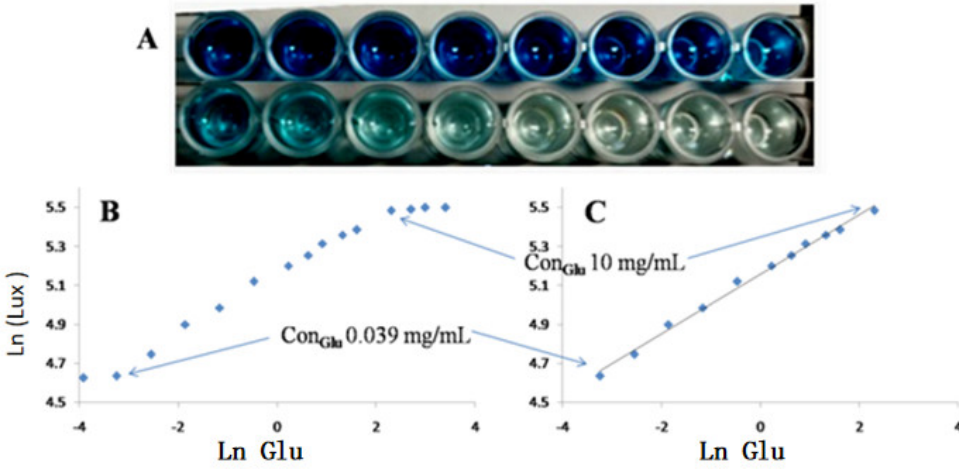
Figure 1. Different colors ( A ) of glucose solutions with different concentrations; linear relationship between LnLux and LnGlu ( B , C ); From figure C, we can see that LnLux and LnGlu have a good linearity and can be used for quantitative analysis in the range of 0.039–10 mg/mL. Hydrogen peroxide (H 2 O 2 ) was generated by the oxidation of glucose in the urine sample under glucose oxidase (GOD) catalysis. Then, the white 3,3′,5,5′-tetramethylbenzidine (TMB red ) was oxidized by horseradish peroxidase (HRP) to its blue oxidized product (TMB ox ) with the participation of H 2 O 2 [22]. Since H 2 O 2 was also the enzyme inhibitor of HRP [23], it could be observed that, with the concentration increase of H 2 O 2 , the blue color of the solution first deepened, then lightened, until it was finally colorless. The color-fading stage was a continuous and gradual process with a long concentration range of H 2 O 2 . With the help of this phenomenon, not only could the qualitative analysis be visualized, but quantitative analysis can also be carried out by using the smartphone. In the present study, quantitative H 2 O 2 was first added to urine to generate the deepest blue. Then, an amount of GOD was added to generate H 2 O 2 by glucose oxidation in the urine. The newly generated H 2 O 2 could shallow the solution color, and we finally used the smartphone ambient-light sensor for data reading, thus realizing the rapid determination of urine glucose. The above procedure is shown in Figure